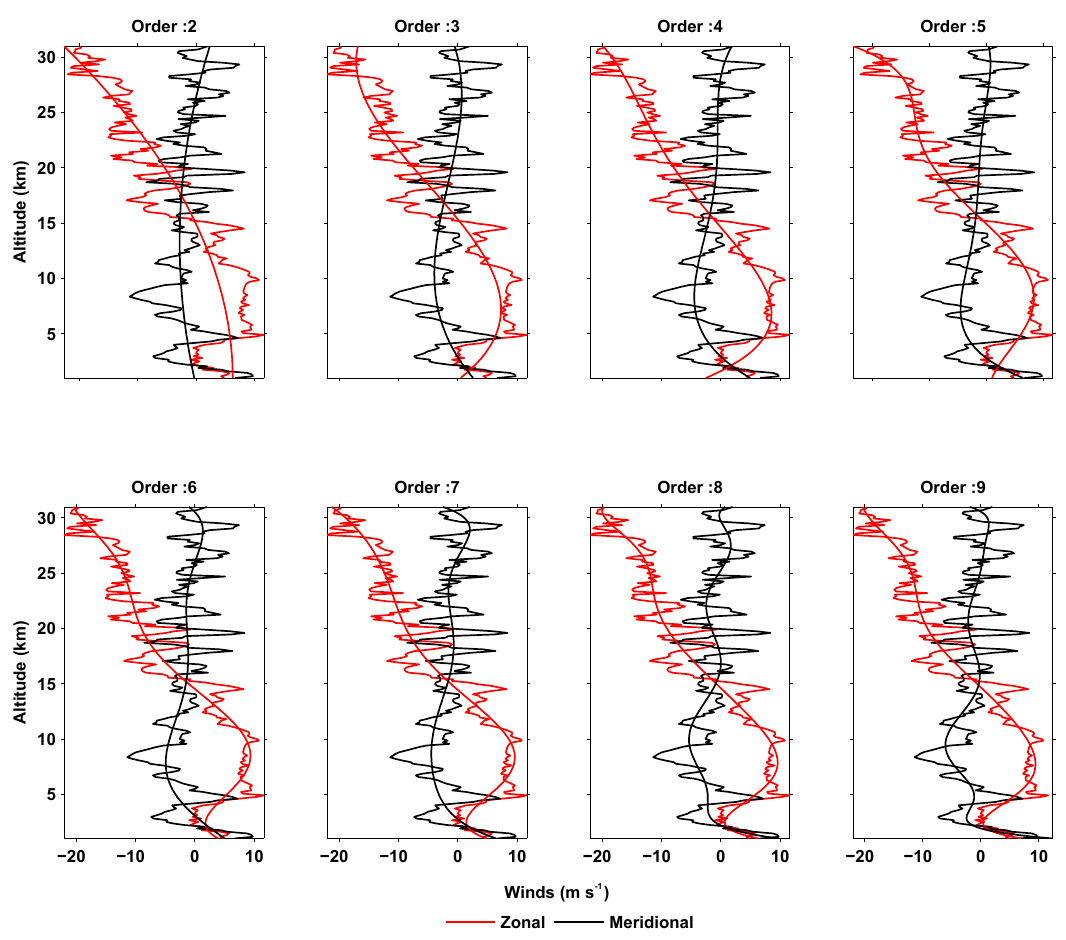
Figure 5. Profiles of zonal and meridional winds (ms − 1 ) and their fits with different orders.